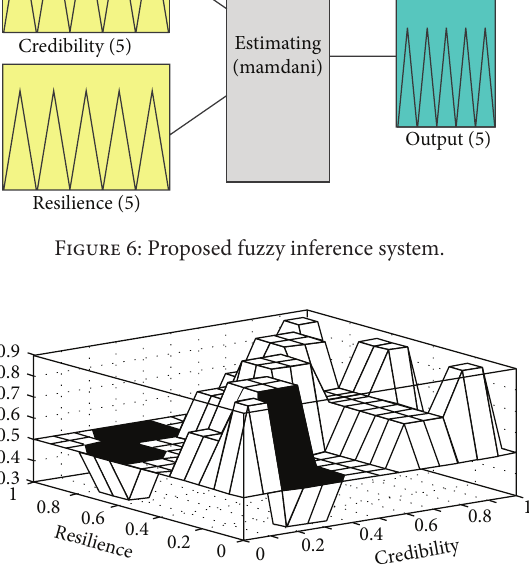
Figure 7: Surface view of inputs and outputs (generated in MAT- LAB).